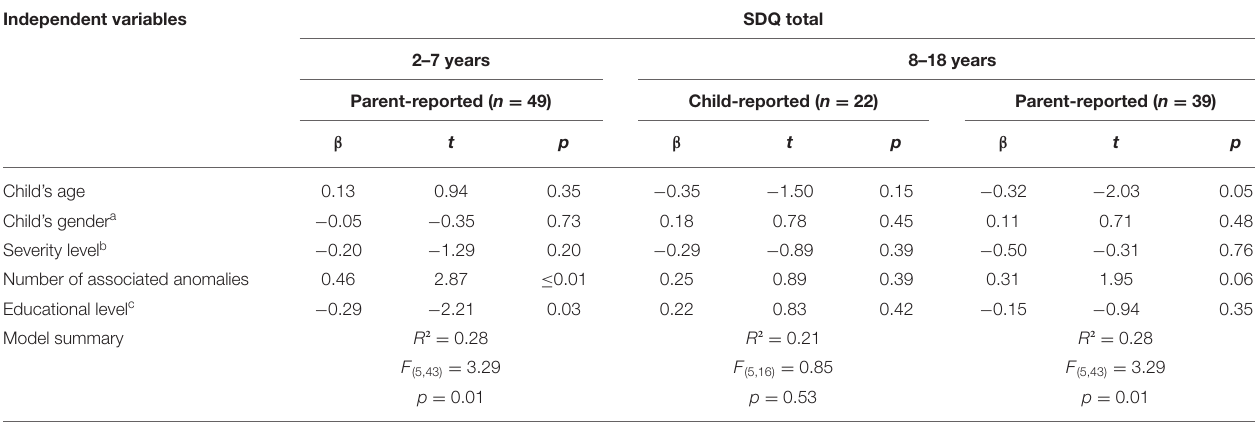
TABLE 6 | Multivariate linear regression: predictors of SDQ total from both child-report and parent-report. Independent